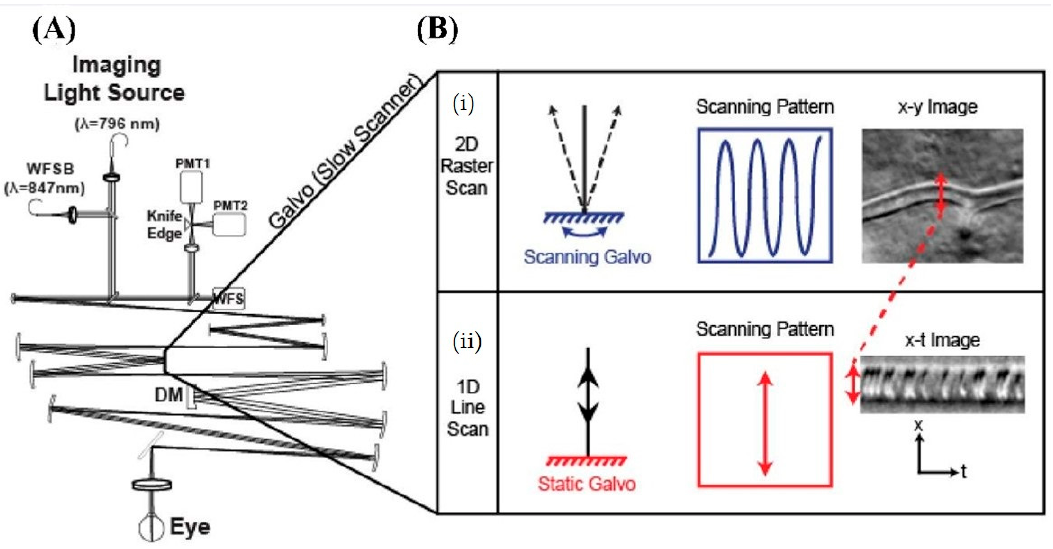
Figure 23. ( A ) Scheme of the scanning imaging system proposed by Guevara-Torres et al., composed of 5 pairs of afocal telescopes that relay coaligned beams for imaging and wavefront sensing. ( B ) The two possible scanning modes: ( i ) 2D raster scan and ( ii ) 1D line scan. See main text for more details. Figure reused from Ref. [119] under the terms of the OSA Open Access Publishing Agreement, © 2016 Optical Society of America.